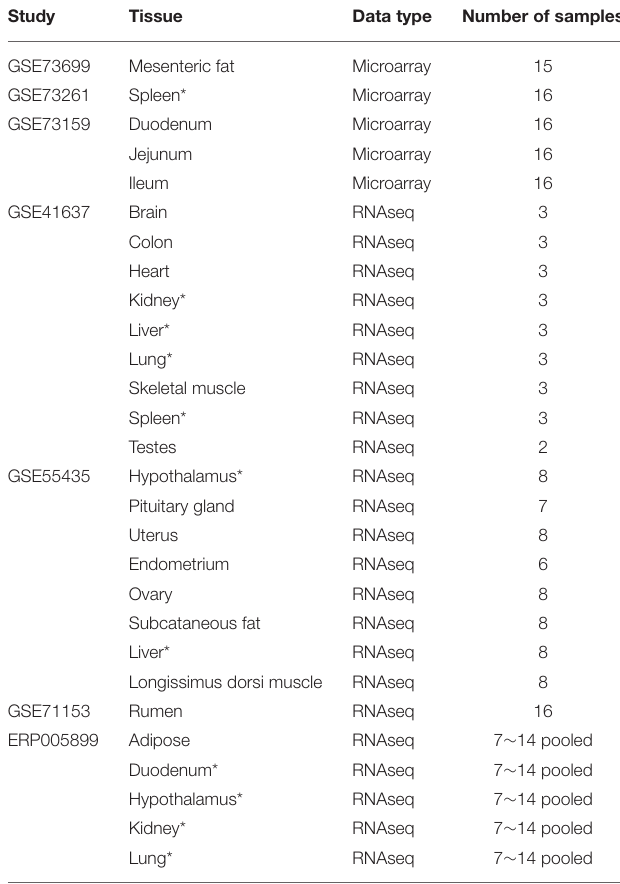
TABLE 2 | Gene expression data